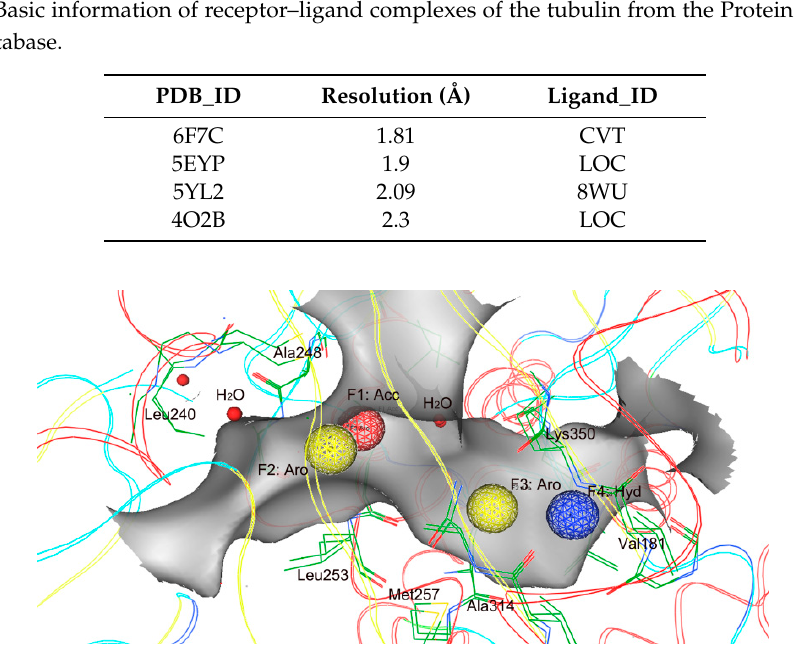
Figure 1. Generated pharmacophore model. Pharmacophore features are color-coded: Red, one hydrogen-bond acceptor feature (F1: Acc); yellow, aromatic features (F2 and F3: Aro); blue, one hydrophobic feature (F4: Hyd). The protein backbone and active site residues (green) are shown in line form; red balls mean water molecules; a gray pocket represents the shape of the binding site in tubulin. Table 1. Basic information of receptor–ligand complexes of the tubulin from the Protein Data Bank (PDB) database.